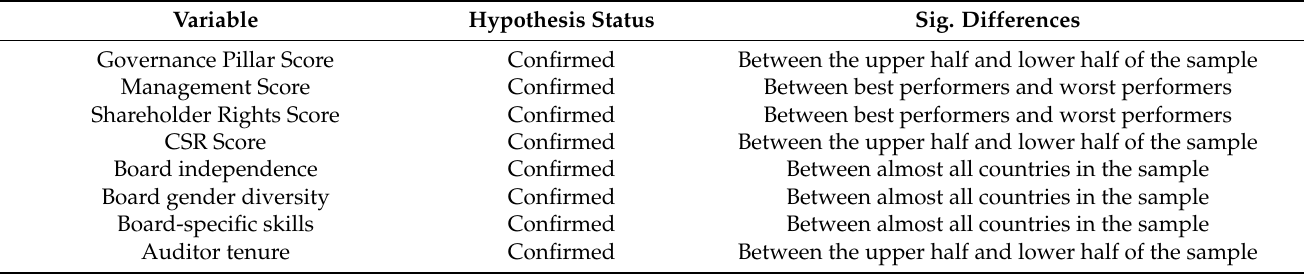
Table 9. A summary of